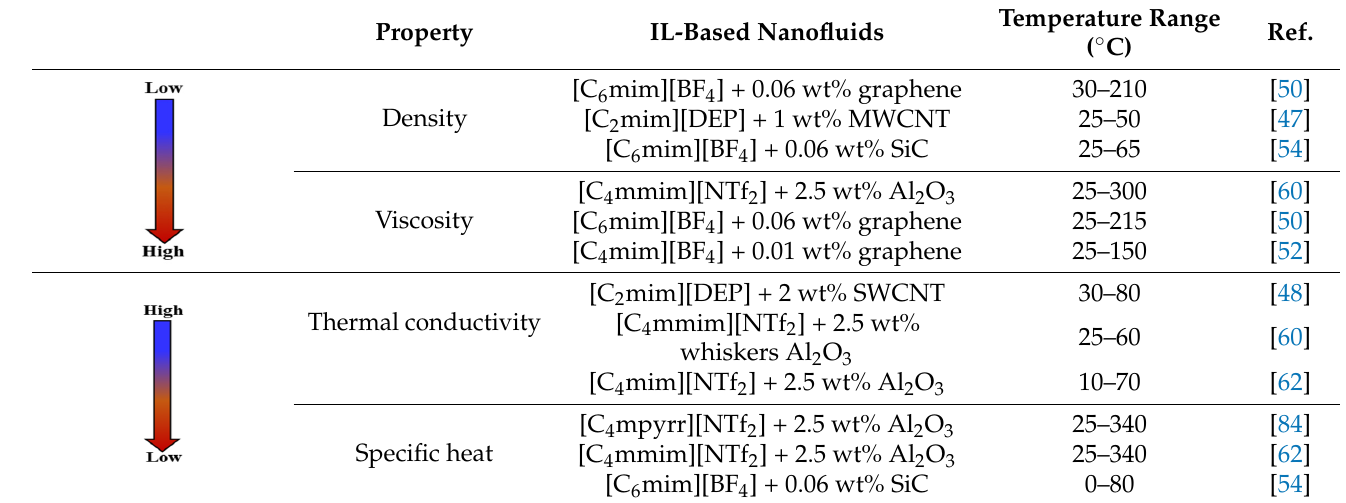
Table 8. Summary of thermophysical properties of ILs-based nanofluids.